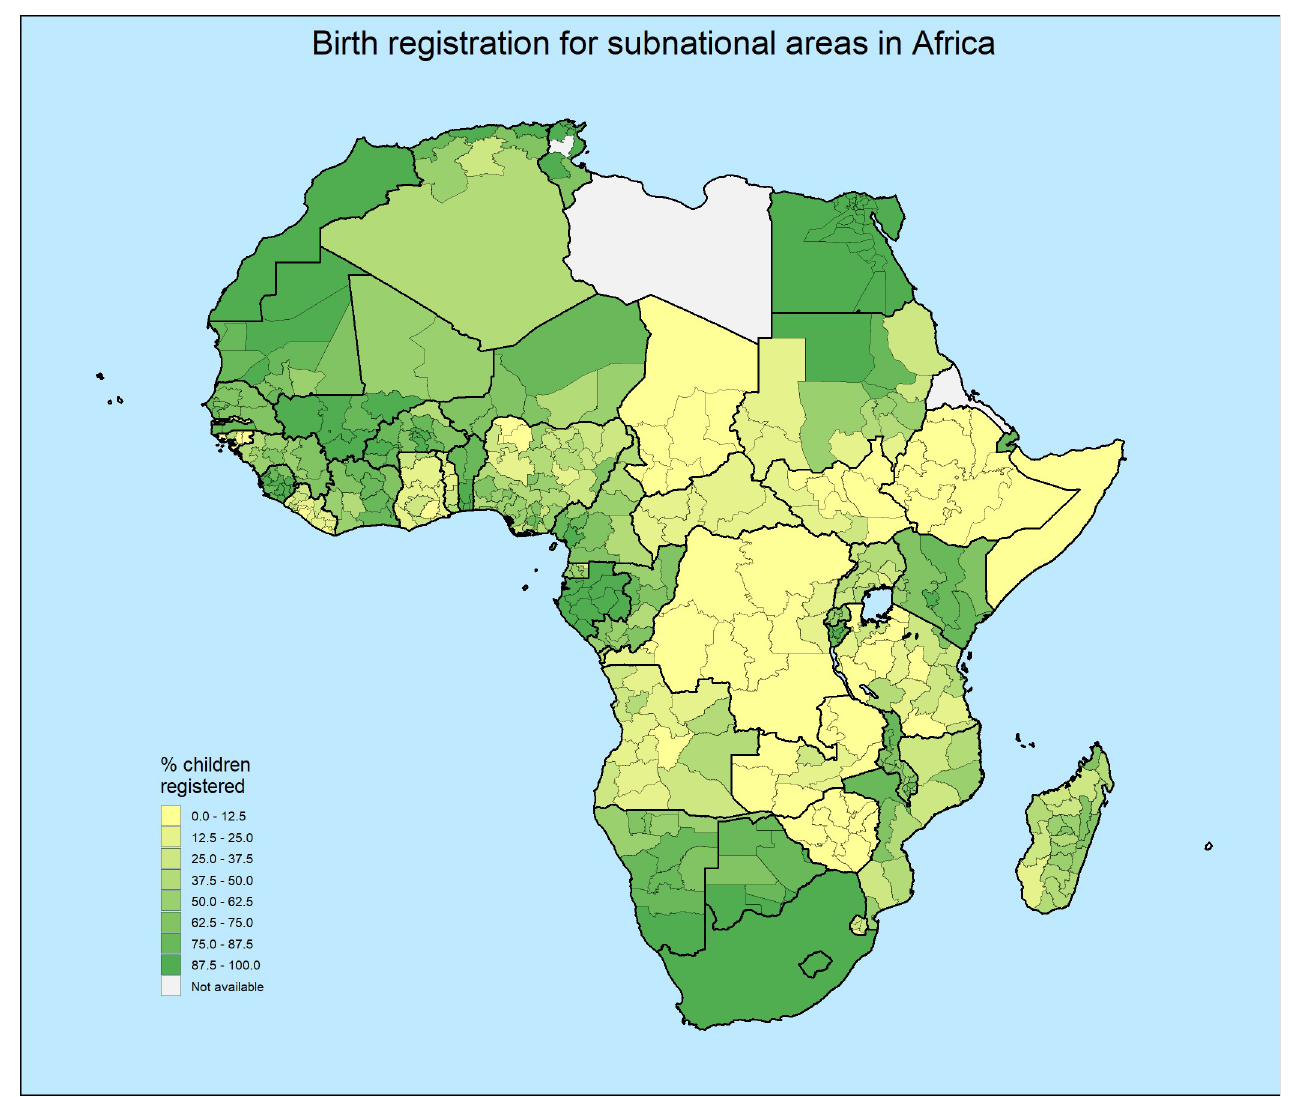
Fig 1. The distribution of countries, years and the number of sub-national regions (provinces). https://doi.org/10.1371/journal.pone.0265882.g001 PLOS ONE | https://doi.org/10.1371/journal.pone.0265882 April 8,